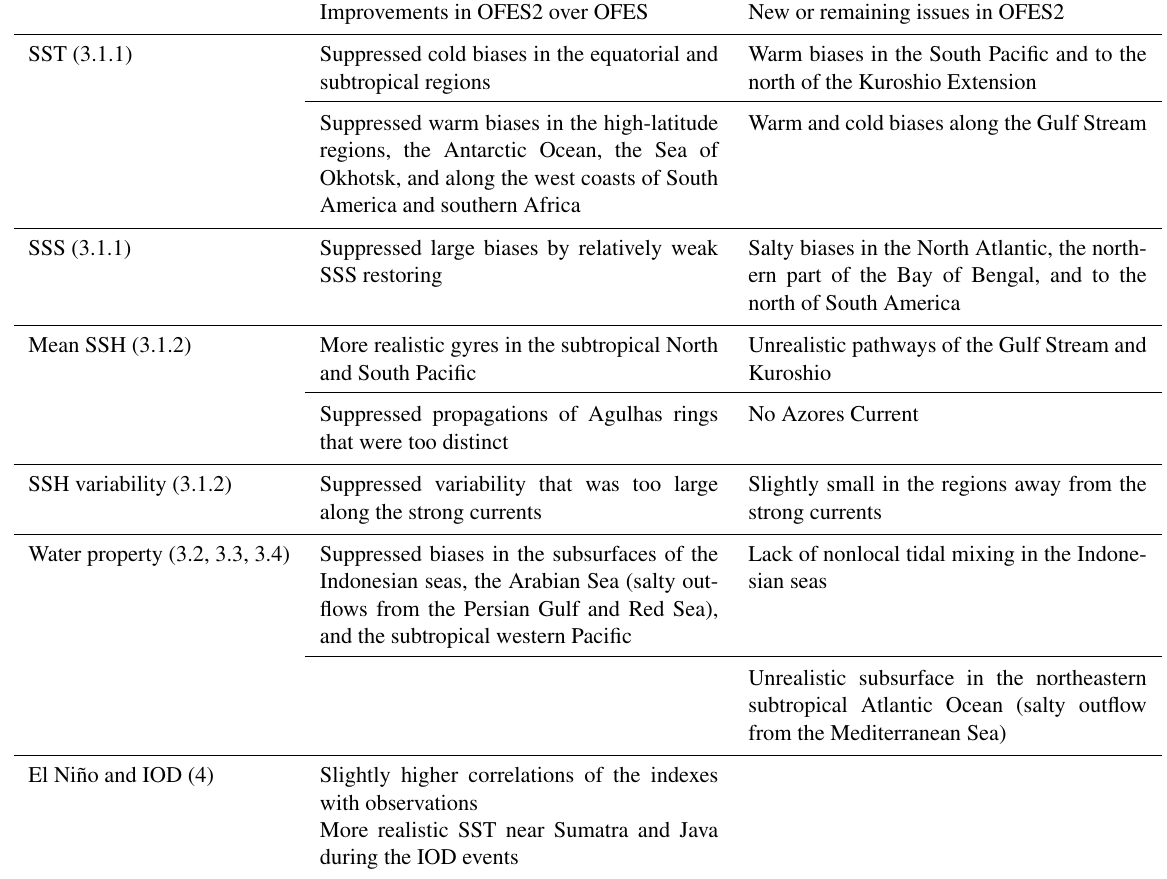
Warm biases in the South Pacific and to the north of the Kuroshio Extension Warm and cold biases along the Gulf Stream Salty biases in the North Atlantic, the north- ern part of the Bay of Bengal, and to the north of South America